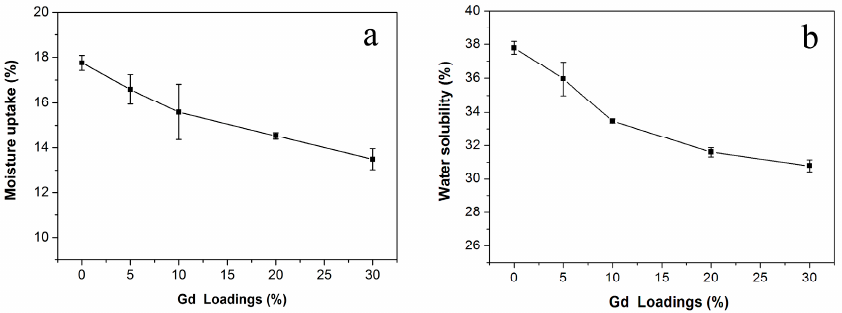
Figure 3. Moisture uptake ( MU ) ( a ) and solubility in water ( WS ) ( b ) of CS/GPs biocomposites with various amounts of added GPs.